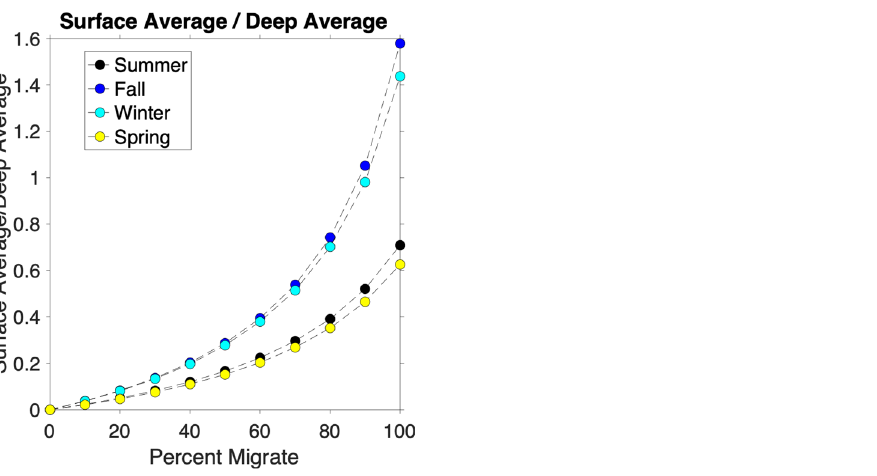
Figure 6. Ratio of average eDNA concentration in the surface to deep layers as a function of percent of individuals that migrate. The x-axis shows the percent of individuals that migrate. The y-axis shows the ratio of the average eDNA concentration in the surface layer (0-100 m) to the average eDNA concentration in the deep layer (450-550 m) for each season.